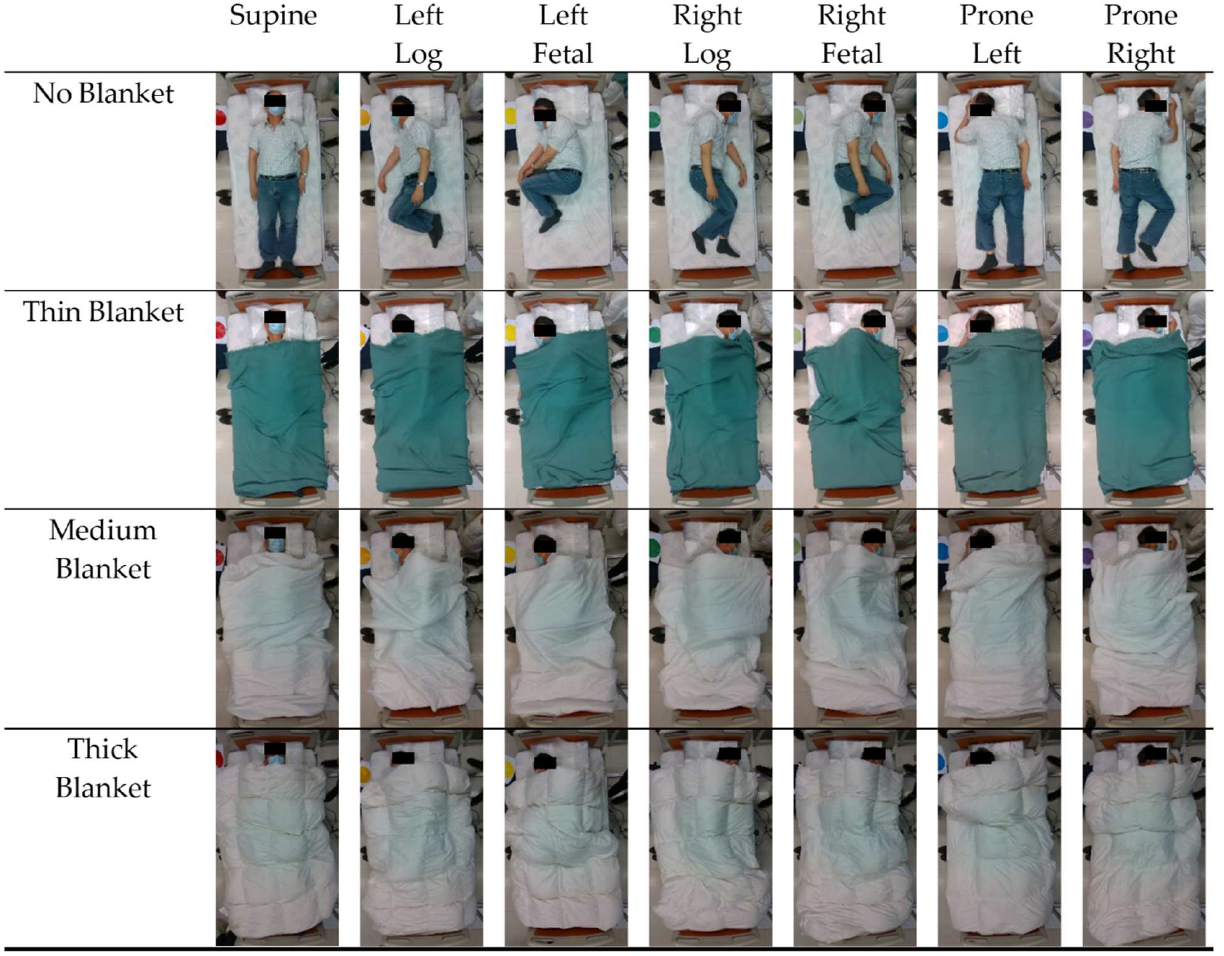
Figure 1. Seven sleep postures classified in the deep learning models: supine, left-sided log, left-sided fetal, right-sided log, right-sided fetal, prone with head turned left, and prone with head turned right.